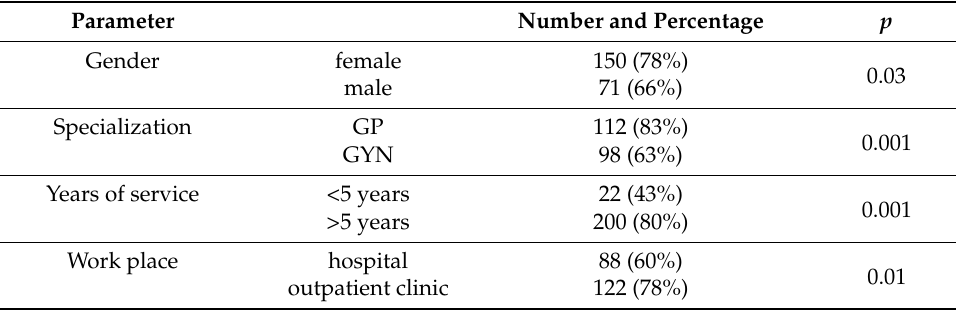
Table 5. Physicians’ willingness to recommend HPV vaccination.